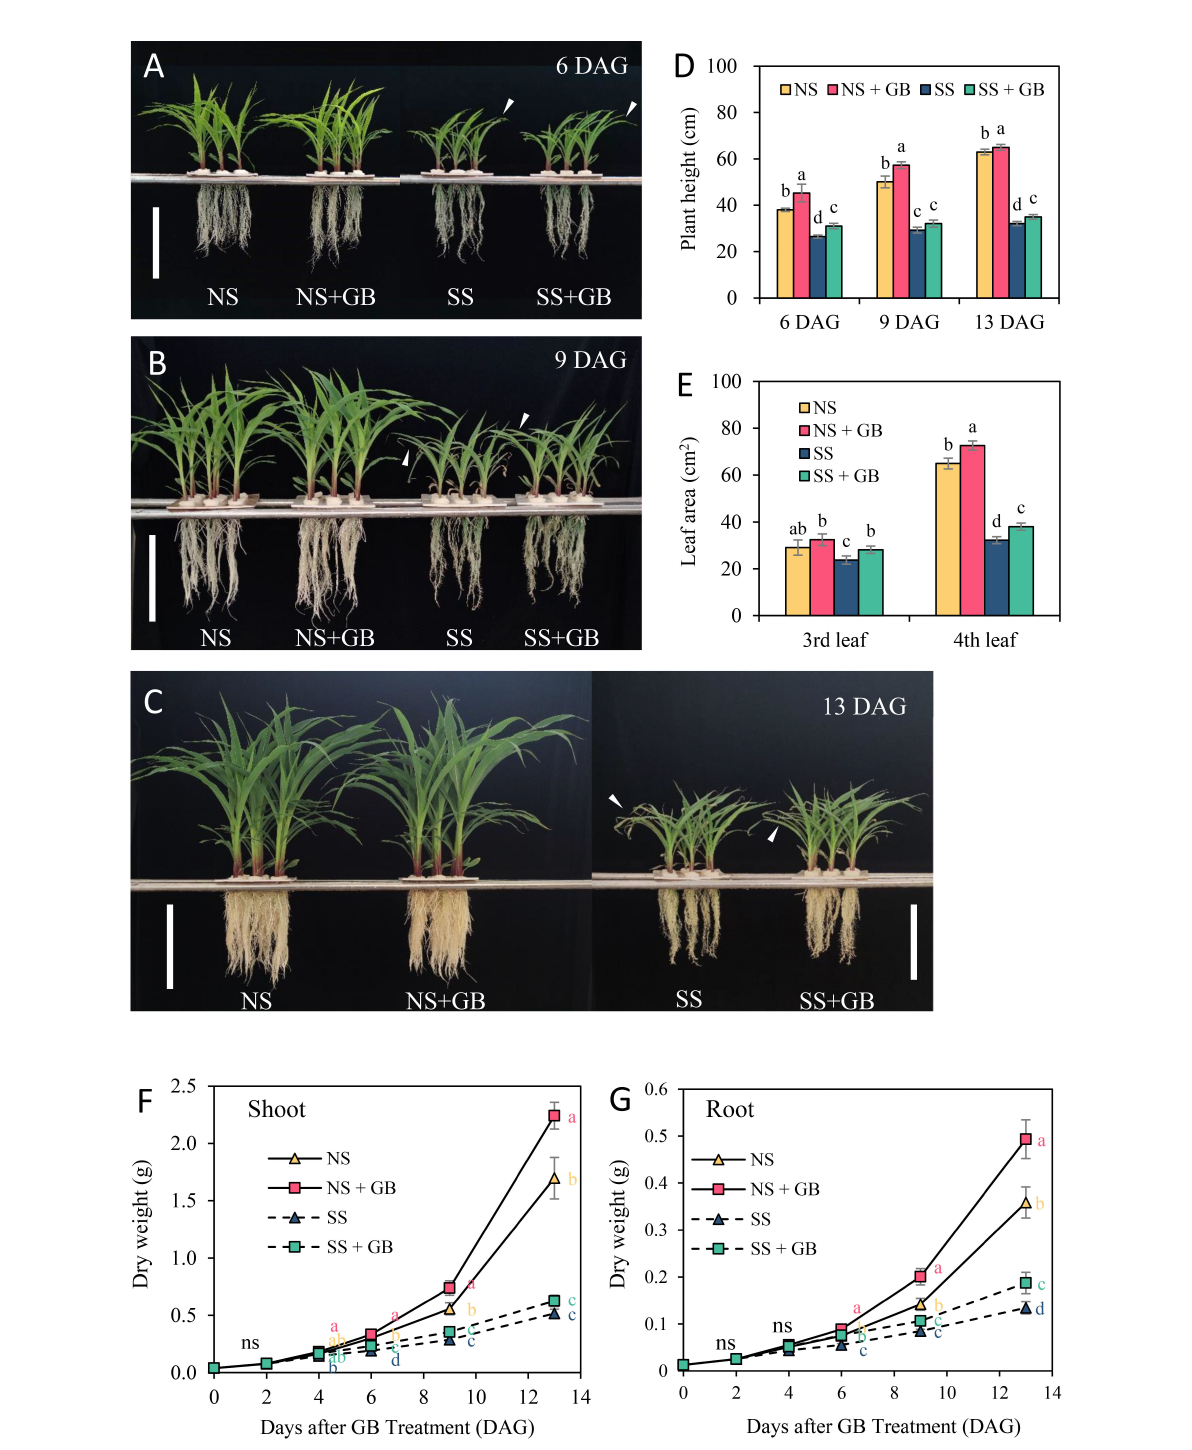
FIGURE 1 Effects of GB on the growth of plants under non-stressed (NS) and salinity-stressed (SS) conditions. Phenotypes of plants treated with 0 and 100 µM GB under NS and SS conditions at (A) 6 days, (B) 9 days and (C) 13 days after GB treatment. White vertical bar = 20 cm. (D) Heights of plants treated with 0 and 100 µM GB under NS and SS conditions. (E) Area of third and fourth leaves at 13 days of treatment. Dry weight of (F) shoots and (G) roots for each of the treatment groups. The values indicate the mean, and the vertical error bars indicate the standard deviation (n = 7). The different letters in each panel represent signi fi cant differences on the same day, as determined with Fisher ’ s protected LSD test at P < 0.05. ns, no signi fi